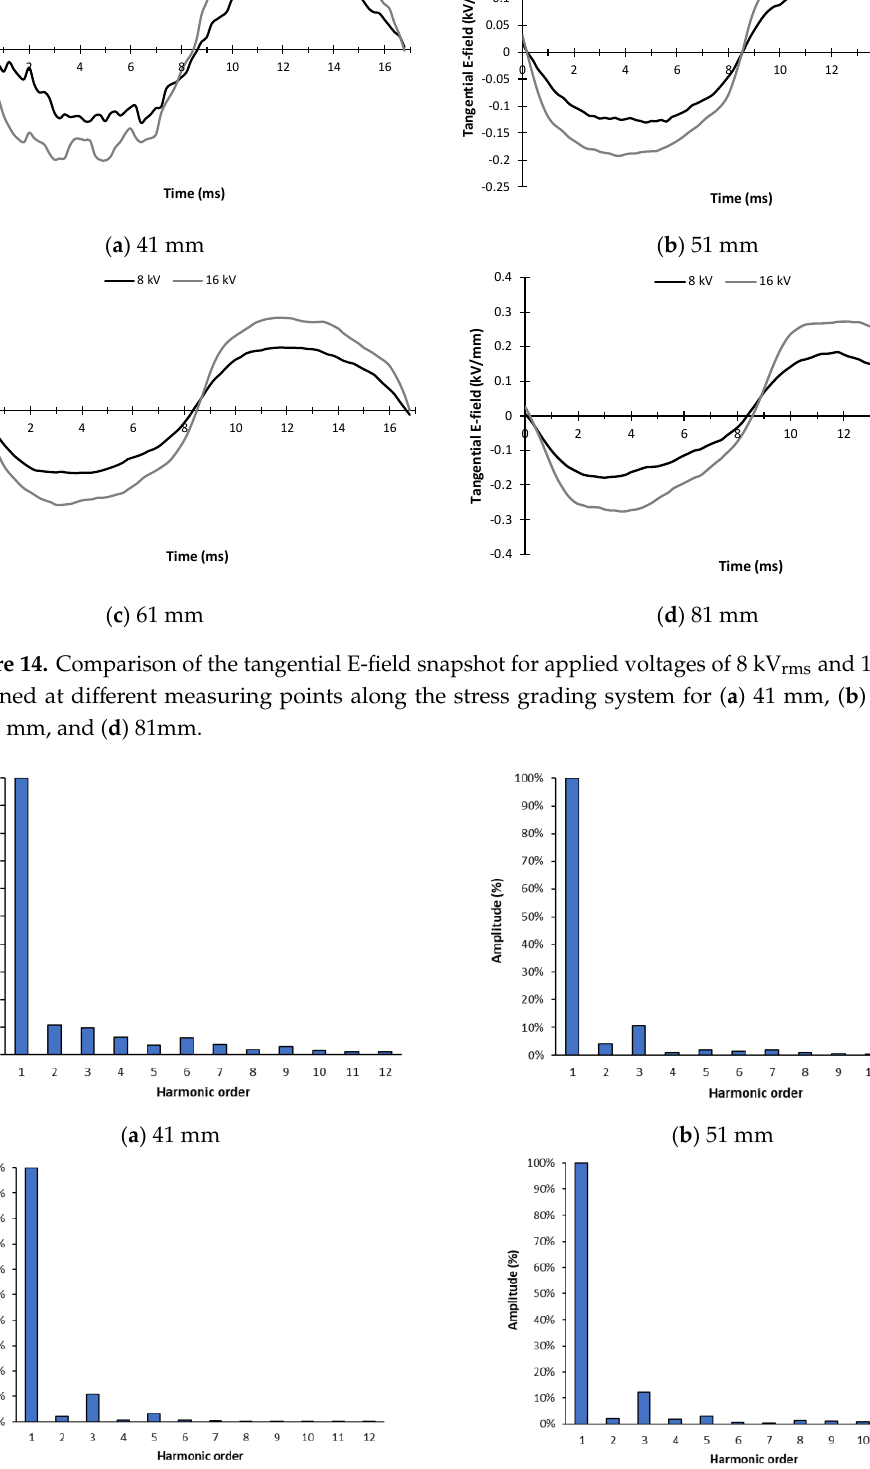
( d ) 81 mm Figure 16. Comparison of the normal E-field snapshot for an applied voltage of 8 kV rms obtained along the stress grading system at ( a ) 41 mm, ( b ) 51 mm, ( c ) 61 mm, and ( d ) 81 mm. -0.2 -0.15 -0.1